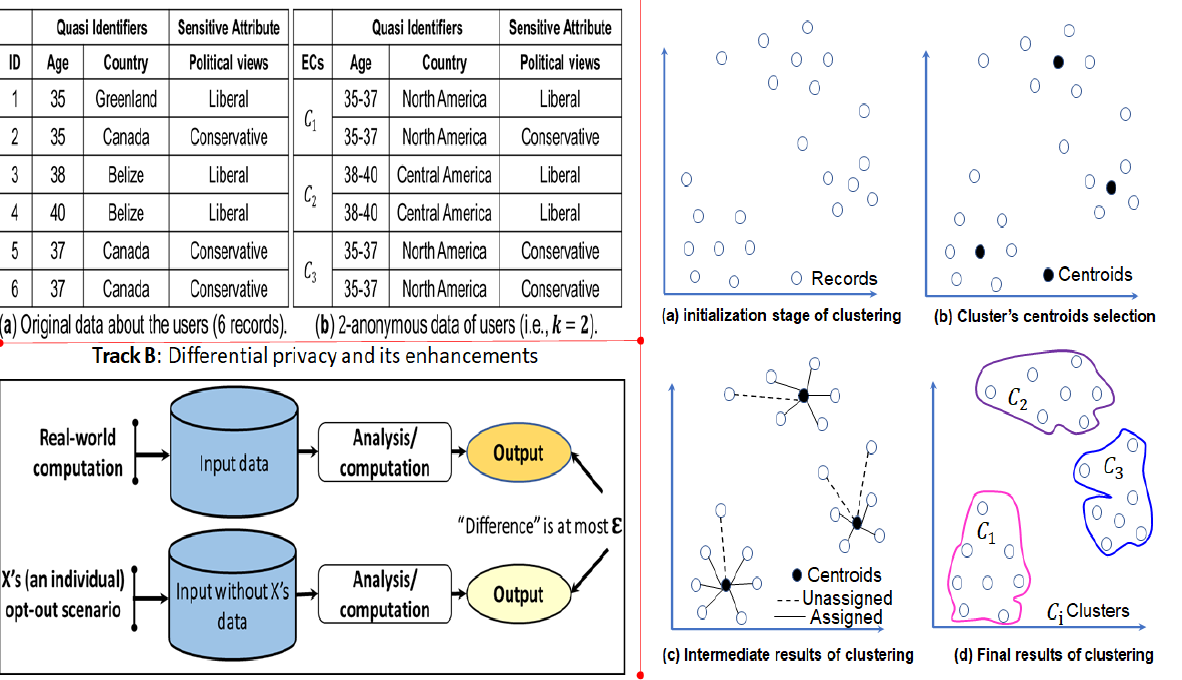
Figure 5. Overview of three main research tracks in individual privacy